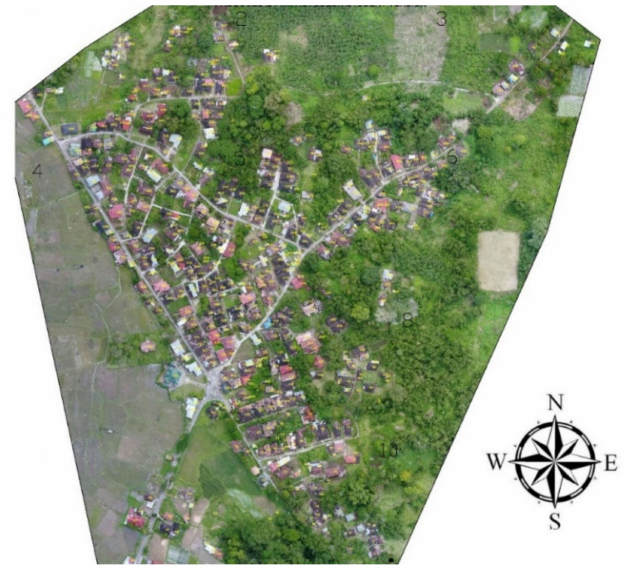
Figure 5. The orthophoto of the study area.